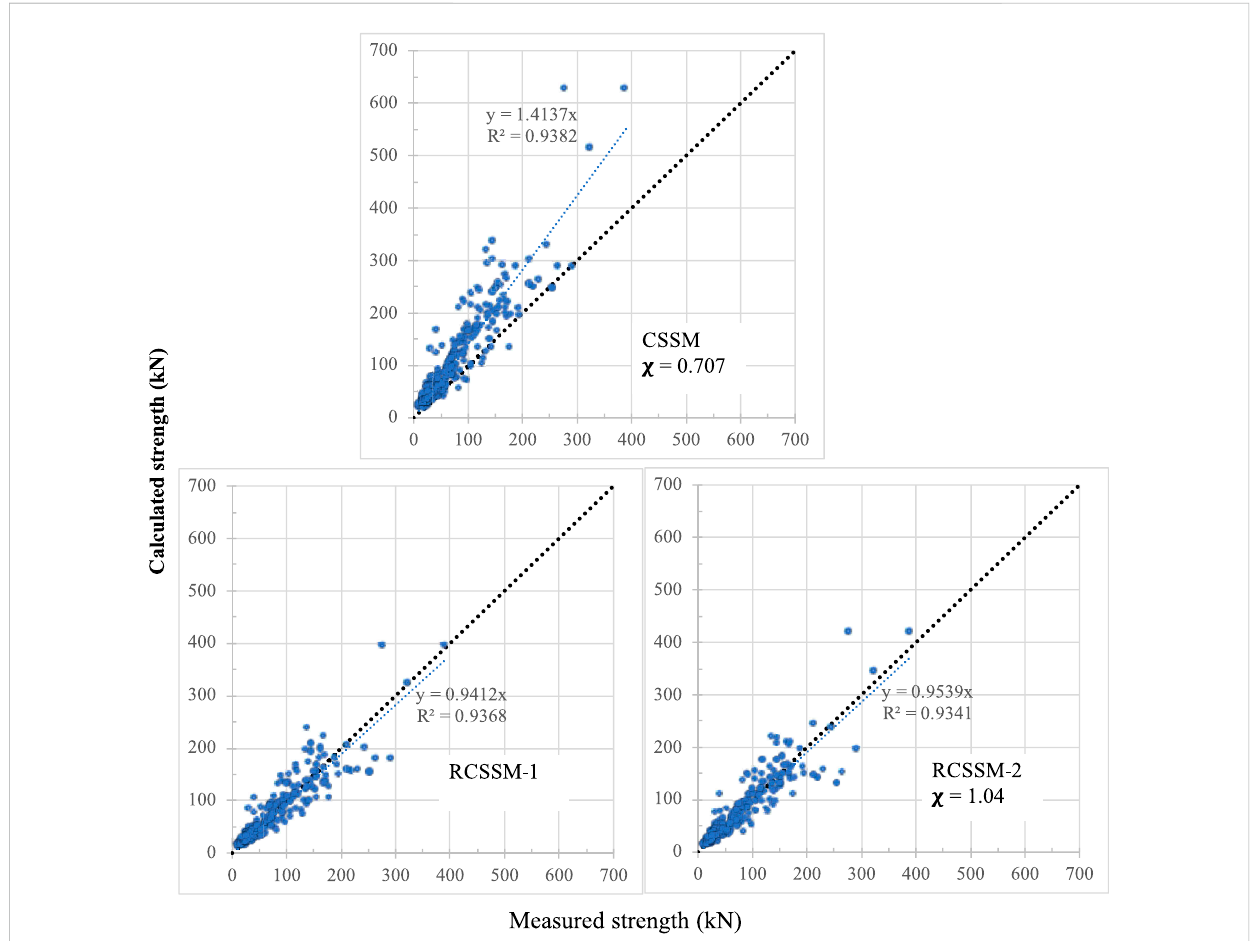
FIGURE 11 Calculated versus measured strength of proposed models.